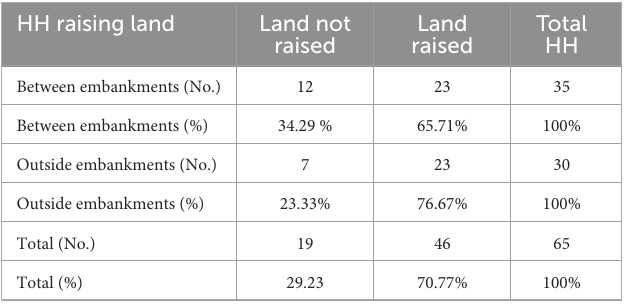
TABLE 7 Number of households raising land based on location.